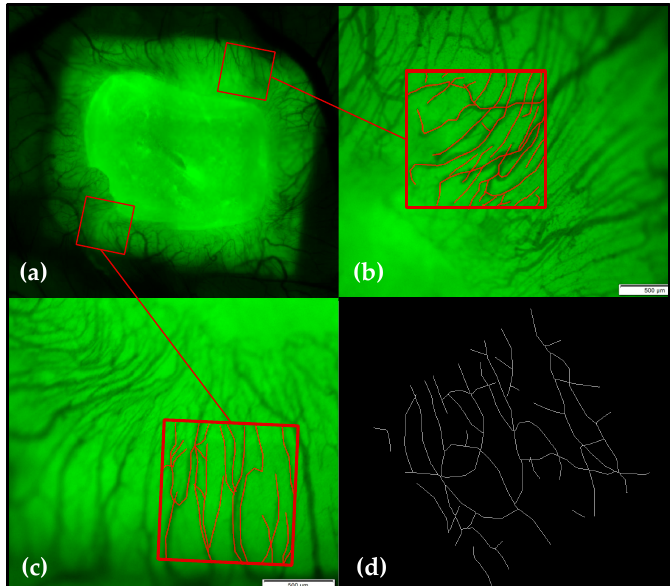
Figure 15. Vessel density and vessel junction analysis. ( a ) The regions of interest (ROIs) were marked within the multiple image array demonstrating the two measured regions chosen within this study. ( b , c ) show the grid 1000 × 1000 µ m in size laid over the image. All vessels visible inside of the square were traced. The software package automatically calculated the length of the marked lines and the area of the ROI. ( d ) The vessel junction analysis was performed using ImageJ. Images were saved in JPEG image format and further edited. Upon receipt of a suitable image form, the structures were image. The scale bar corresponds to a length of 2